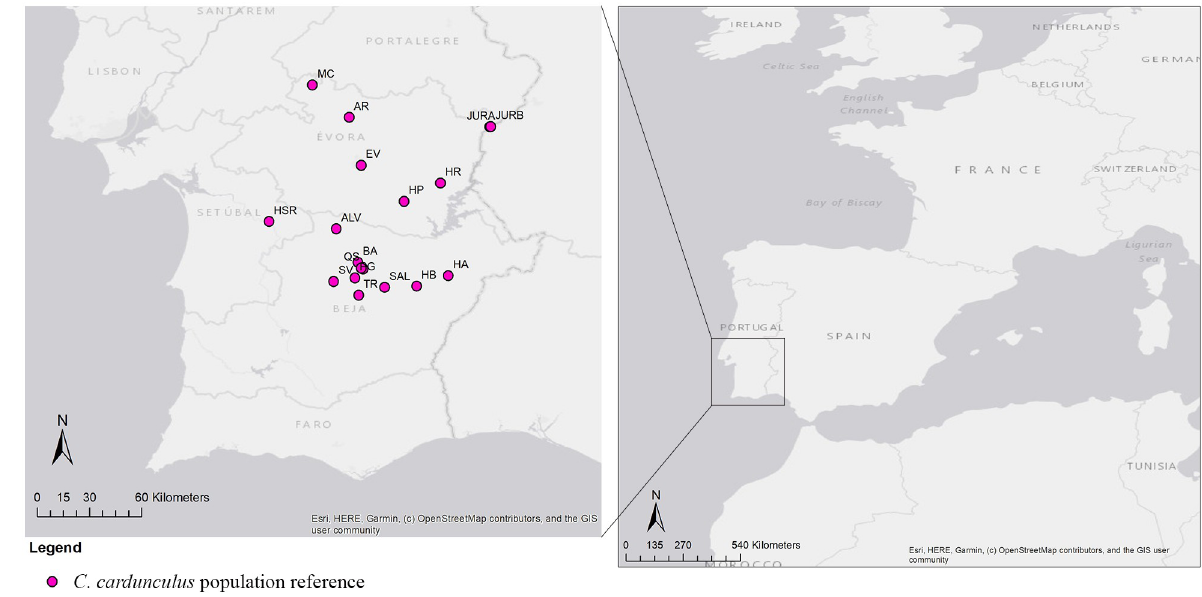
Fig 1. Maps indicating geographic locations and distribution of the wild populations of Cynara cardunculus , sampled in